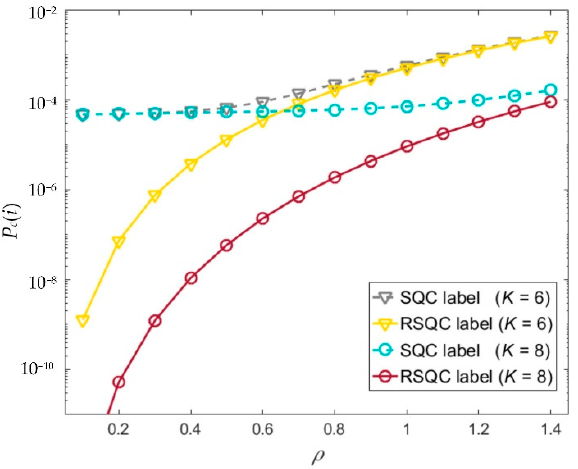
Figure 4. Functions from traffic intensity to code-error rate.